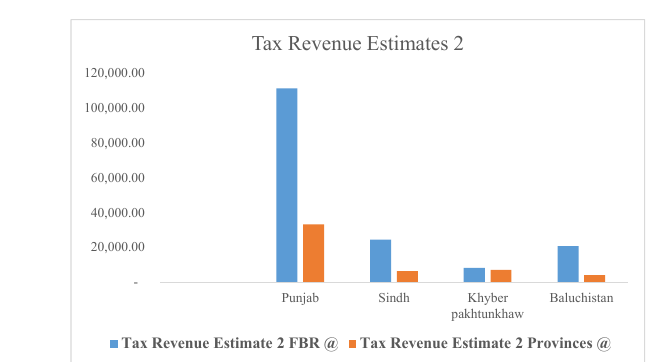
Fig. 4: Tax revenue estimate 2; based on the authors estimates reported in Appendices 5-6